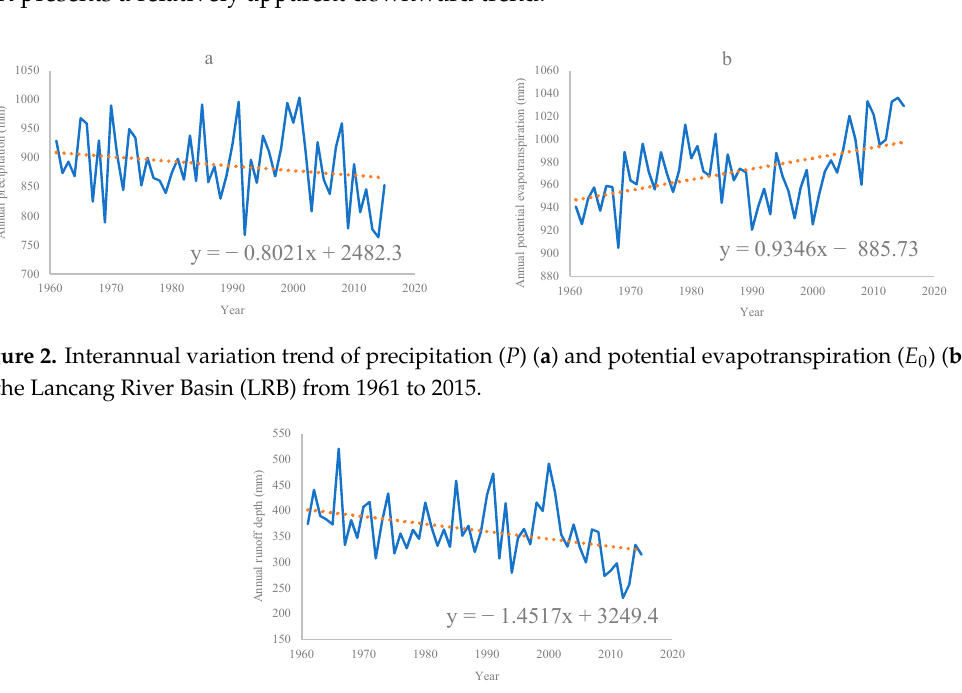
Figure 3. Interannual variation trend of runoff ( R ) of Yunjinghong hydrometric station from 1961 to 2015.